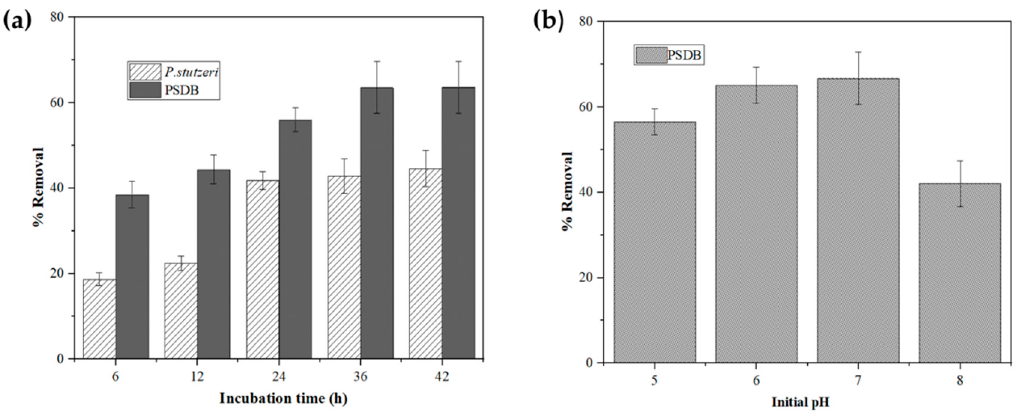
Figure 6. Ni 2+ removal by PSDB; ( a ) effect of incubation time; ( b ) effect of initial